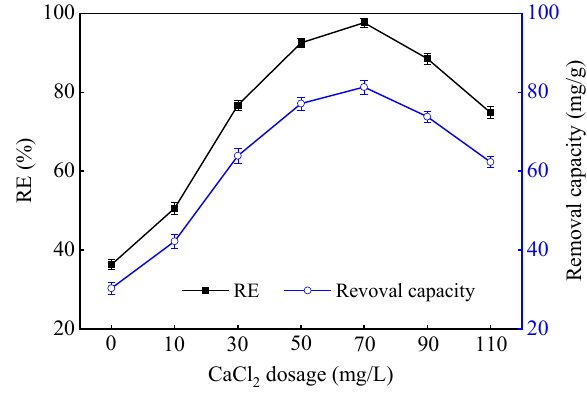
Figure 2: Effects of bioflocculant dosage on the removal of Pb(II) from aqueous solution. [Error bars refer to standard deviation (3 replicates for each treatment)].